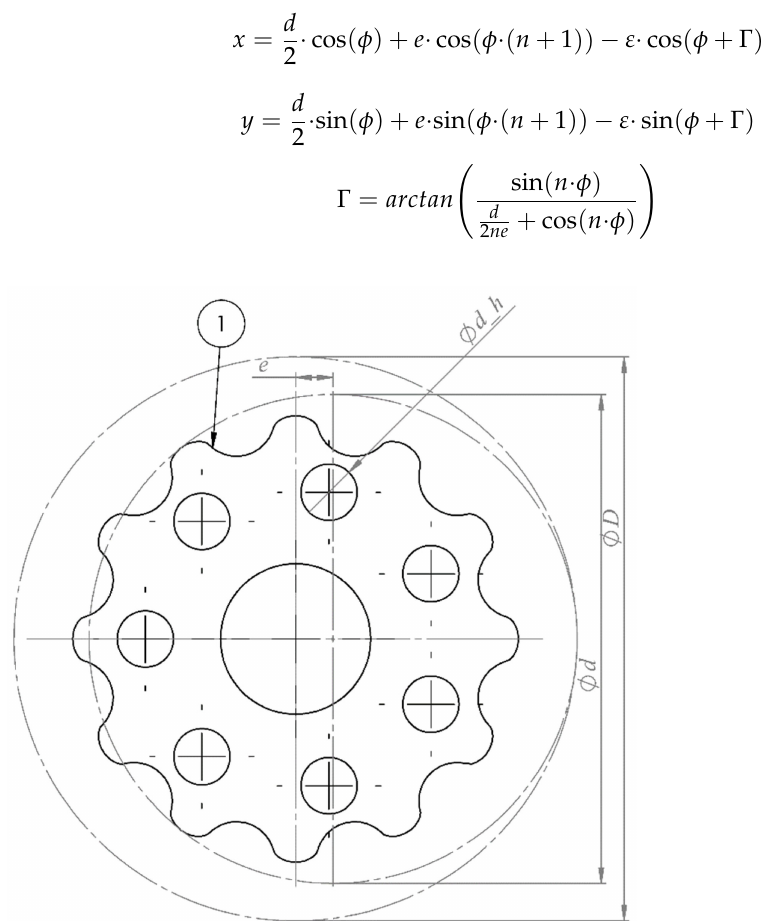
Figure 2. Cycloid disc profile with the important metrics highlighted: e —eccentricity, d h —hole diameters, D —reference circle diameter of the fixed ring pins, d —base circle diameter, and 1 (cid:13) indicates a